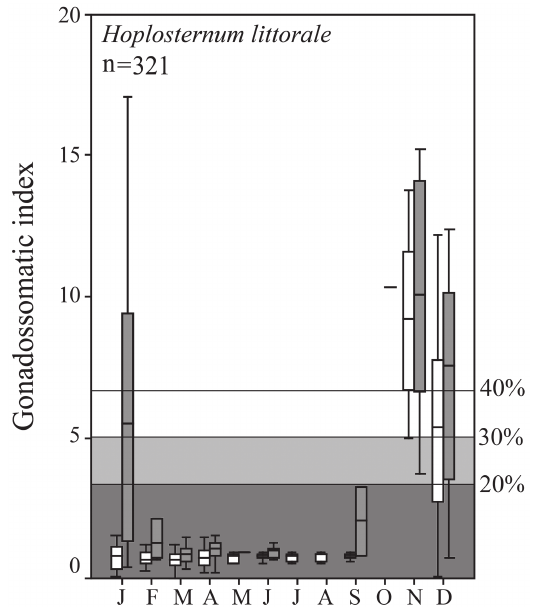
Fig. 7. Monthly variation of Hoplosternum littorale GSI values Fig. 9. Monthly variation of Parapimelodus nigribarbis (adult females only) in Guaíba Lake (white) and Casamento GSI values (adult females only) in Guaíba Lake (white) and Lake (dark gray), Rio Grande do Sul, Brazil (median, 25-75% Casamento Lake (dark gray), Rio Grande do Sul, Brazil (median, quartiles and lower-upper GSI limits by month and site). Three 25-75% quartiles and lower-upper GSI limits by month and GSI cut-off values were tested with respect to the maximum site). Three GSI cut-off values were tested with rspect to the GSI recorded for each species, for delimitation of reproductive maximum GSI recorded for each species, for delimitation of months: 20% (G ), 30% (G ) and 40% (G ). reproductive months: 20% (G ), 30% (G ) and 40% (G 20 30 40 20 30 40